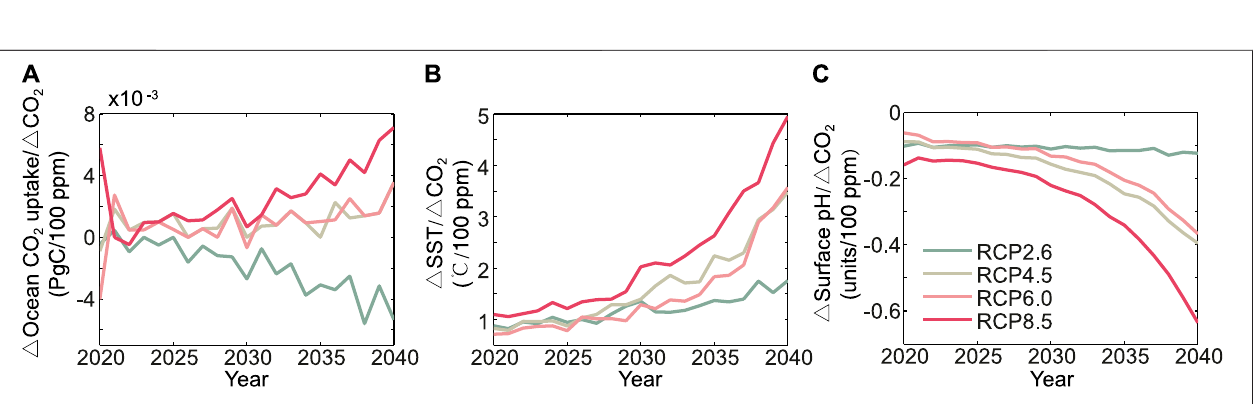
FIGURE 9 | Model-simulated time series of (A) Δ oceanic CO 2 uptake/ Δ CO 2 , (B) Δ sea surface temperature/ Δ CO 2 , and (C) Δ sea surface pH/ Δ CO 2 in Zhejiang offshore. Results are shown for the four simulations using the four RCP scenarios depicted in the Data and Modeling section.